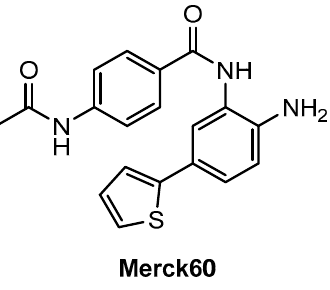
Figure 8. Chemical structure of